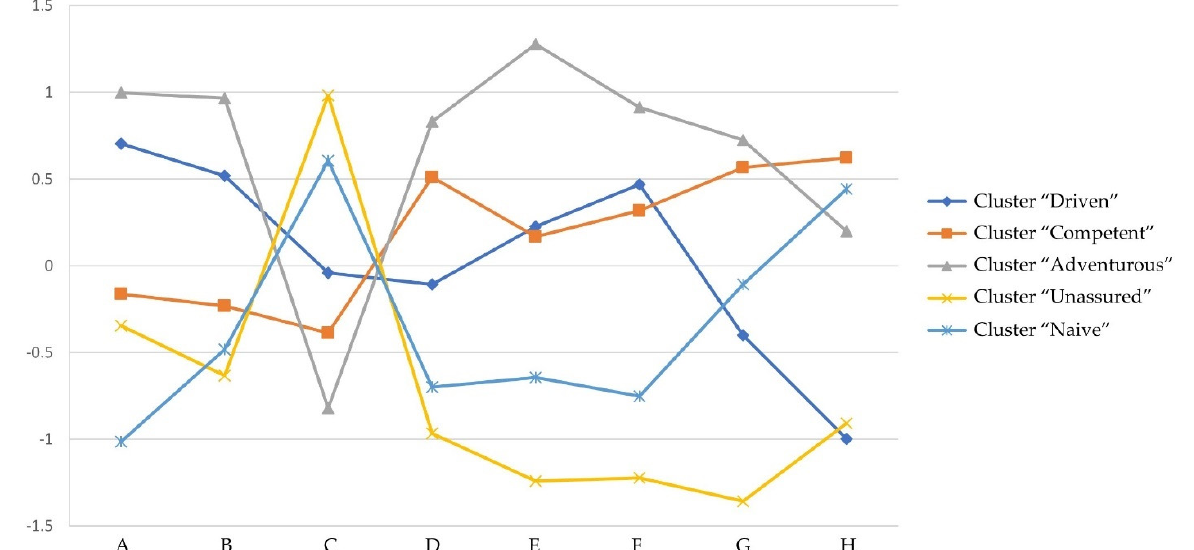
Figure 1. Cluster profiles by standardized mean values of Sexual Self components. A = Sexual Arousal; B = Sexual Exploration; C = Sexual Anxiety; D = Sexual Self-Esteem: Attractiveness; E = Sexual Self-Esteem: Behavior; F = Sexual Self-Esteem: Conduct; G = Sexual Self-Efficacy: Assertive; H = Sexual Self-Efficacy: Resistive.